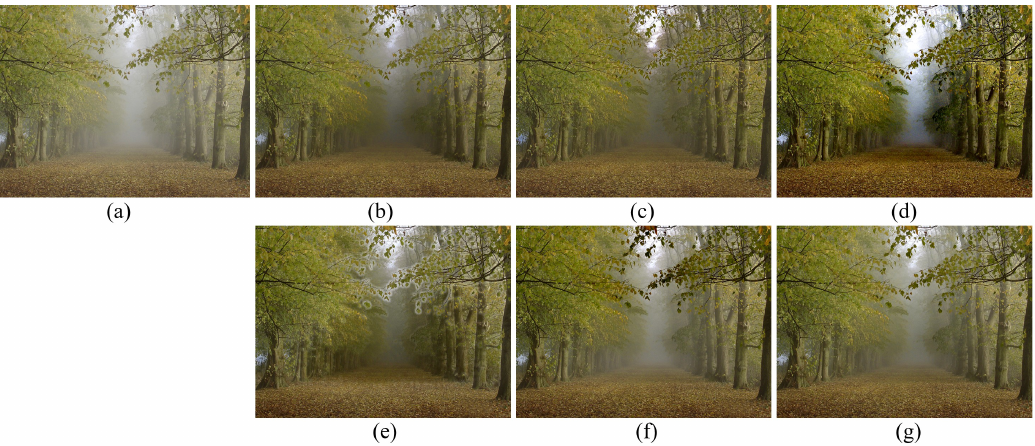
Figure 9. Experimental results of haze removal using the proposed and existing methods: ( a ) an input haze image [1], reproduced with permission from [1], IEEE, 2011, ( b ) He’s method [1], ( c ) Meng’s method [9], reproduced with permission from [9], IEEE, 2013, ( d ) Berman’s method [8], reproduced with permission from [8], IEEE, 2016, ( e ) Zhu’s method [2], ( f ) Ren’s method [6], and ( g ) the proposed